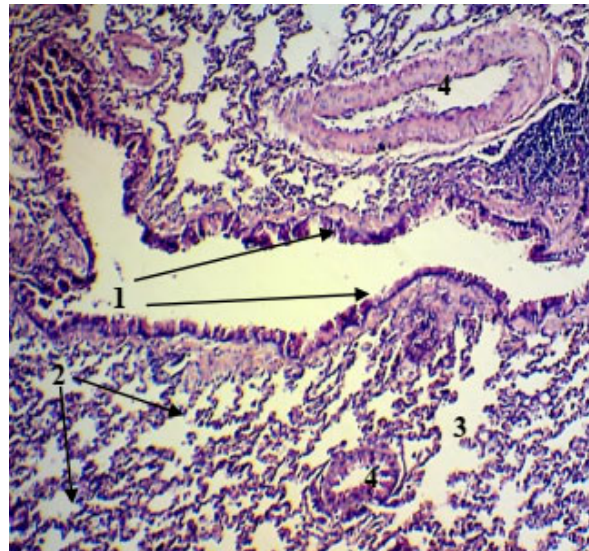
Fig. 1. Macroscopic structure of the lungs of a mature rabbit: 1 – left lung; 2 – reduced apical lobe; 3 – cardiac lobe; 4 – diaphragmatic lobe; 5 – right lung; 6 – apical lobe; 7 – cardiac lobe; 8 – diaphragmatic lobe; 9 – acces- sory lobe. Macropreparation